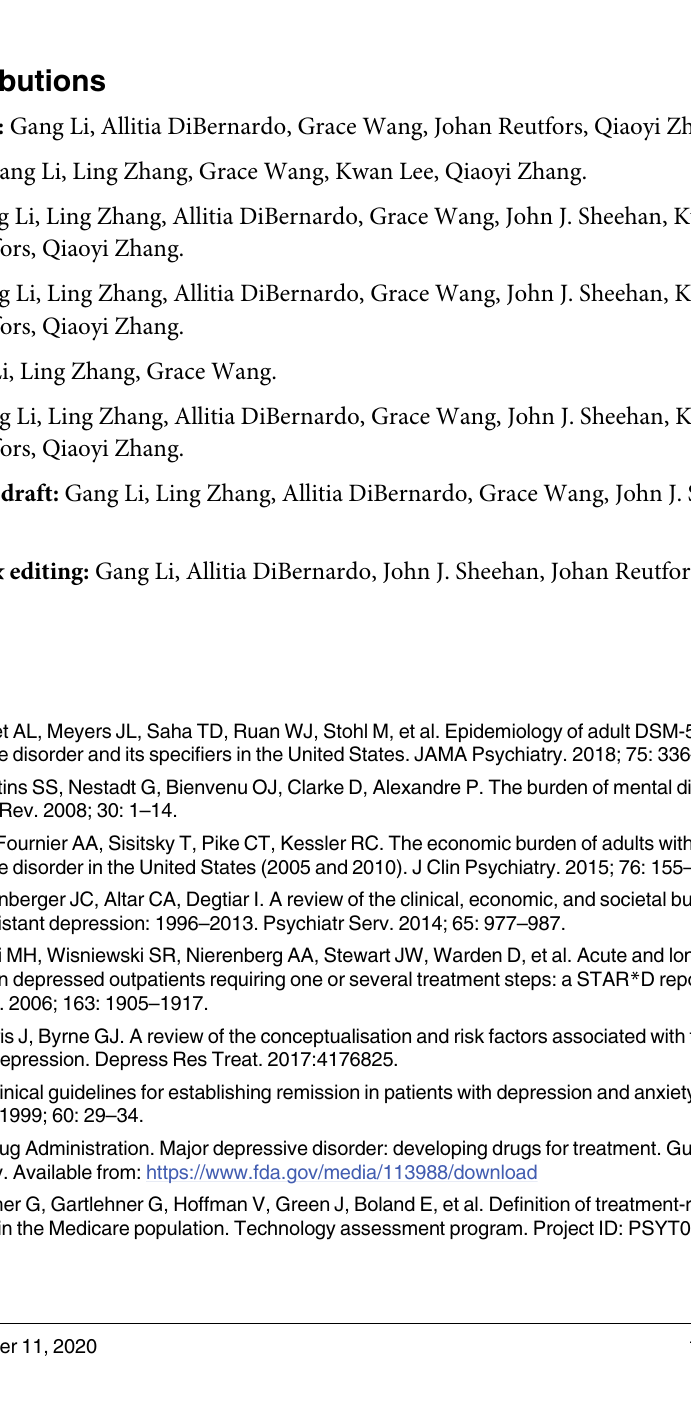
S4 Table. Demographic and clinical characteristics of patients with treatment-resistant depression and non–treatment-resistant depression before and after the propensity score matching at 1:1 ratio. S5 Table. Healthcare resource utilization per year during the study period (matched at 1:1 ratio). S6 Table. Comparison of costs per year between treatment-resistant depression and non– treatment-resistant major depressive disorder patients (US$; matched at 1:1 ratio) a